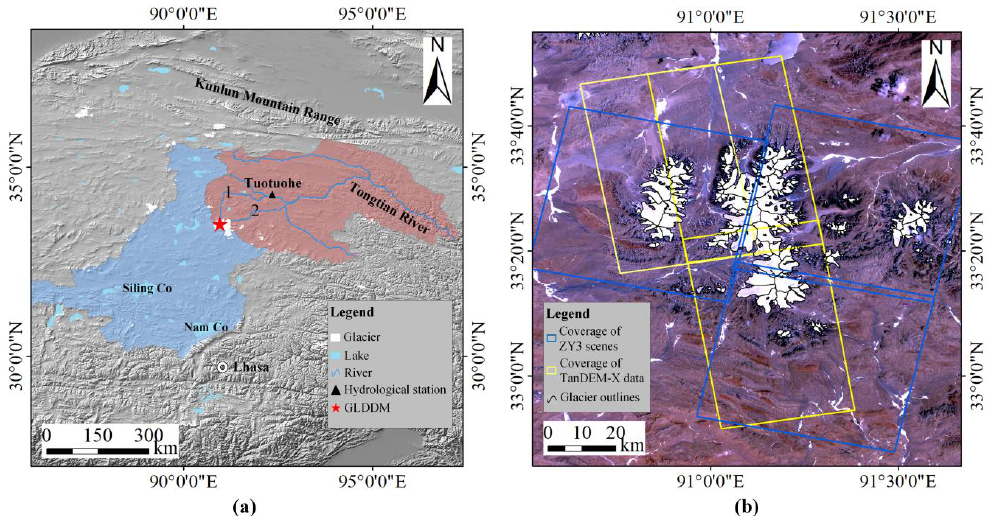
Figure 1. ( a ) Locations of the Geladandong mountain (GLDDM) and the Tuotuohe hydrological station in the Tibetan Plateau. The source region of the Yangtze River (SRYR) is in pink and the endorheic basin of the Tibetan Plateau is in blue. In the SRYR, the glacier melt-water of the GLDDM flows into the Tuotuo River (No. 1) and the Garang River (No. 2). ( b ) Glacierized regions of the GLDDM and the coverage of ZY-3 images and TanDEM-X data. Glacier boundaries were obtained from the Second Chinese Glacier Inventory [47]. Background: Landsat Thematic Mapper image in 1999 (Red, Band3; Green, Band2; Blue, Band1).